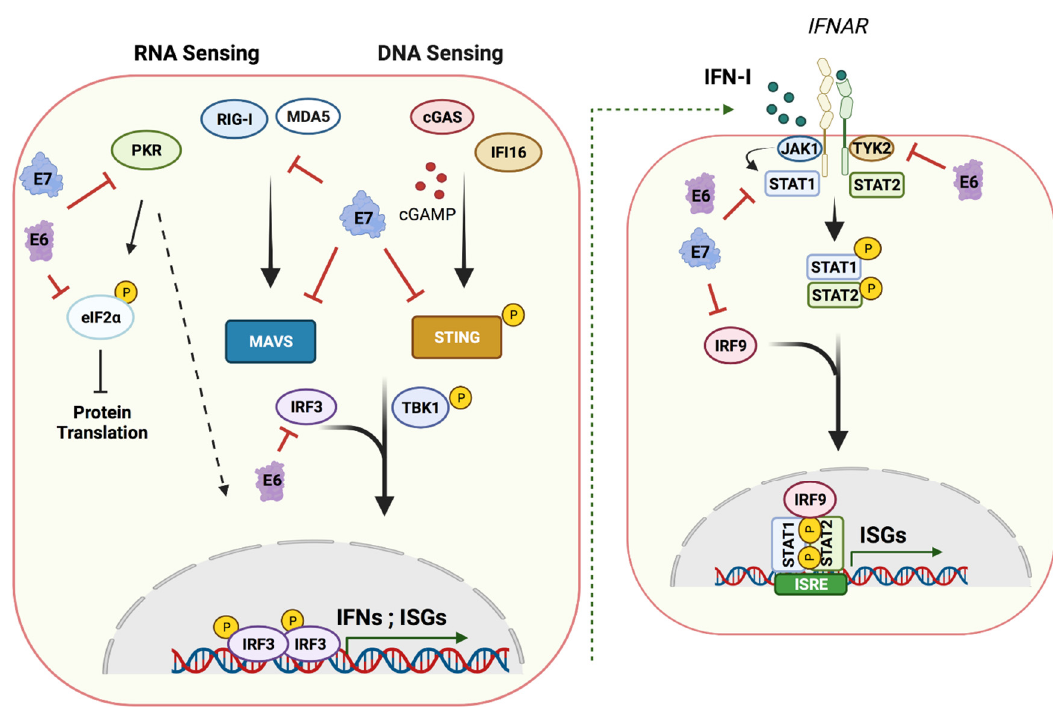
Figure 3. Host nucleic acid sensing pathways and targets of E6 and E7. A cartoon showing cytoplasmic nucleic acid sensors and their signaling cascades inducing type I IFN production and ISG expression that are targeted by E6 and E7 (left panel). A cartoon showing the effects of secreted IFNs on neighboring cells through activation of the JAK–STAT pathway leading to an antiviral state (right). HPV oncoproteins E6 and E7 manipulate these pathways at different stages, damping the innate immune response and establishing a persistent infection. (Created with BioRender.com).